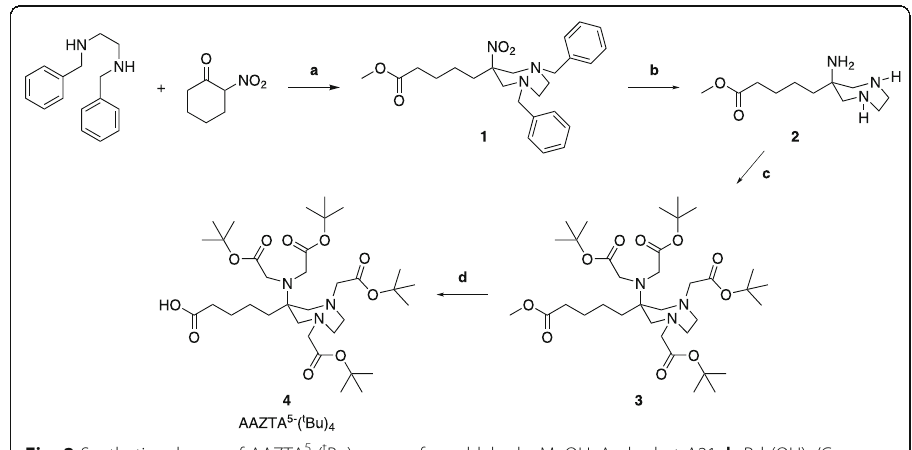
Fig. 2 Synthetic scheme of AAZTA 5 -( t Bu) 4 : a paraformaldehyde, MeOH, Amberlyst A21; b Pd (OH) 2